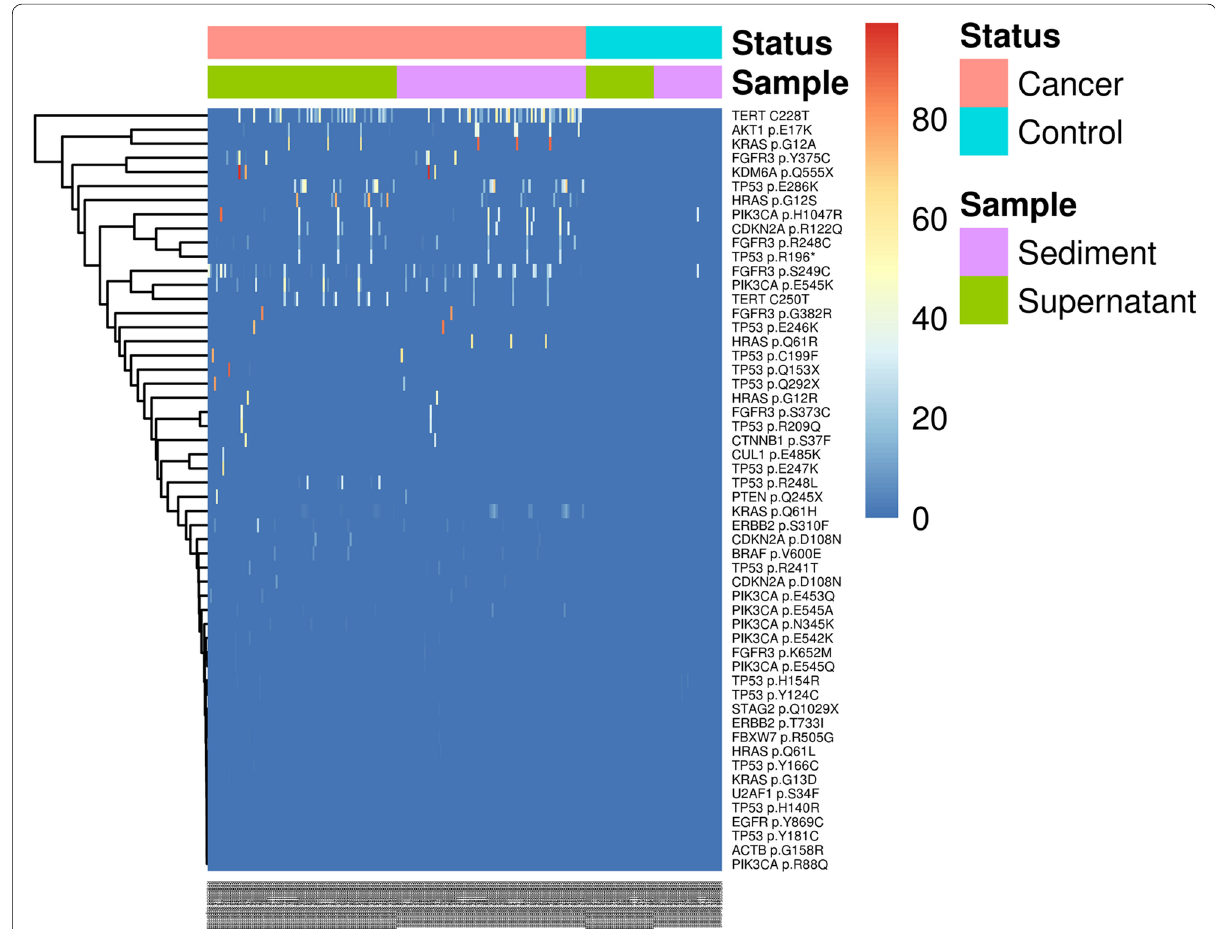
Fig. 3 Heatmap illustrating the distribution of mutation rates identified in the DNA of urine supernatant and urine sediments. In cancer tissue, high mutation rates were identified in KDM6A p.Q555X, KRAS pG2A, TP53 p.Q153X, TERT promoter, FGFR3 p.Y375C, and TP53 p.E246K. The Y-axis lists the mutation locations and the X-axis shows the identification number of each sample. The mutation rates from low to high are represented by their colors from blue (low) to red (high)